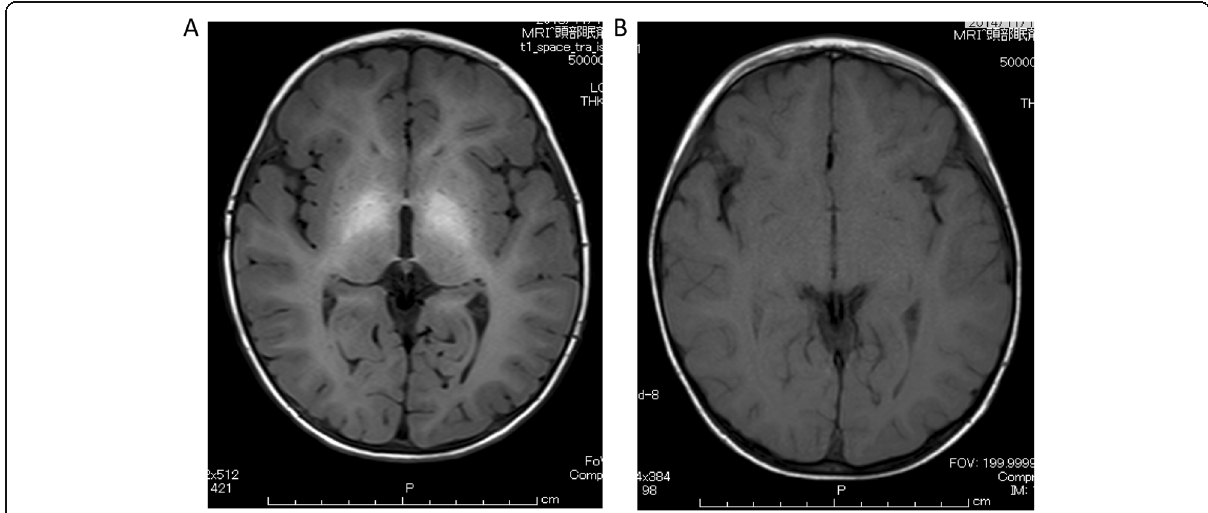
Fig. 1 Magnetic resonance imaging of brain. a Magnetic resonance imaging (MRI) of the brain at the age of 1 year and 3 months, revealing high intensity of the pallidum. b MRI at 8 months postoperatively, revealing normalization of the high intensity of the